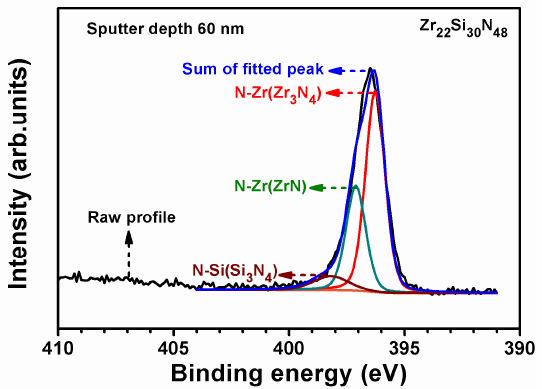
Figure 8. XPS profiles of N 1s core levels of Zr 22 Si 30 N 48 (0.4,R5) coatings at a depth of 60 nm.